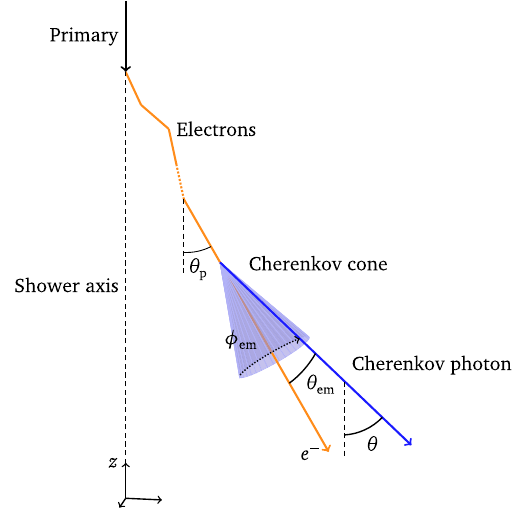
Fig. 1 Definition of the relevant angles for Cherenkov light emission in air showers. The blue cone represents the emission of Cherenkov photons around the emitting electron trajectory, in orange. The final angle between each Cherenkov photon (blue trajectory) and the shower axis is denoted by